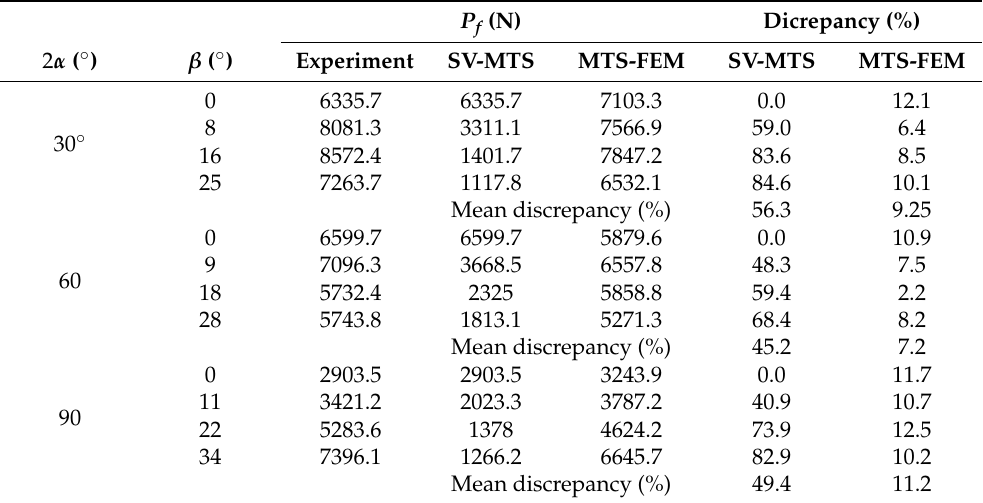
Table 3. Comparison between the fracture load predictions in rock (marble) SVBD samples obtained from SV-MTS and MTS-FEM criteria and experimental